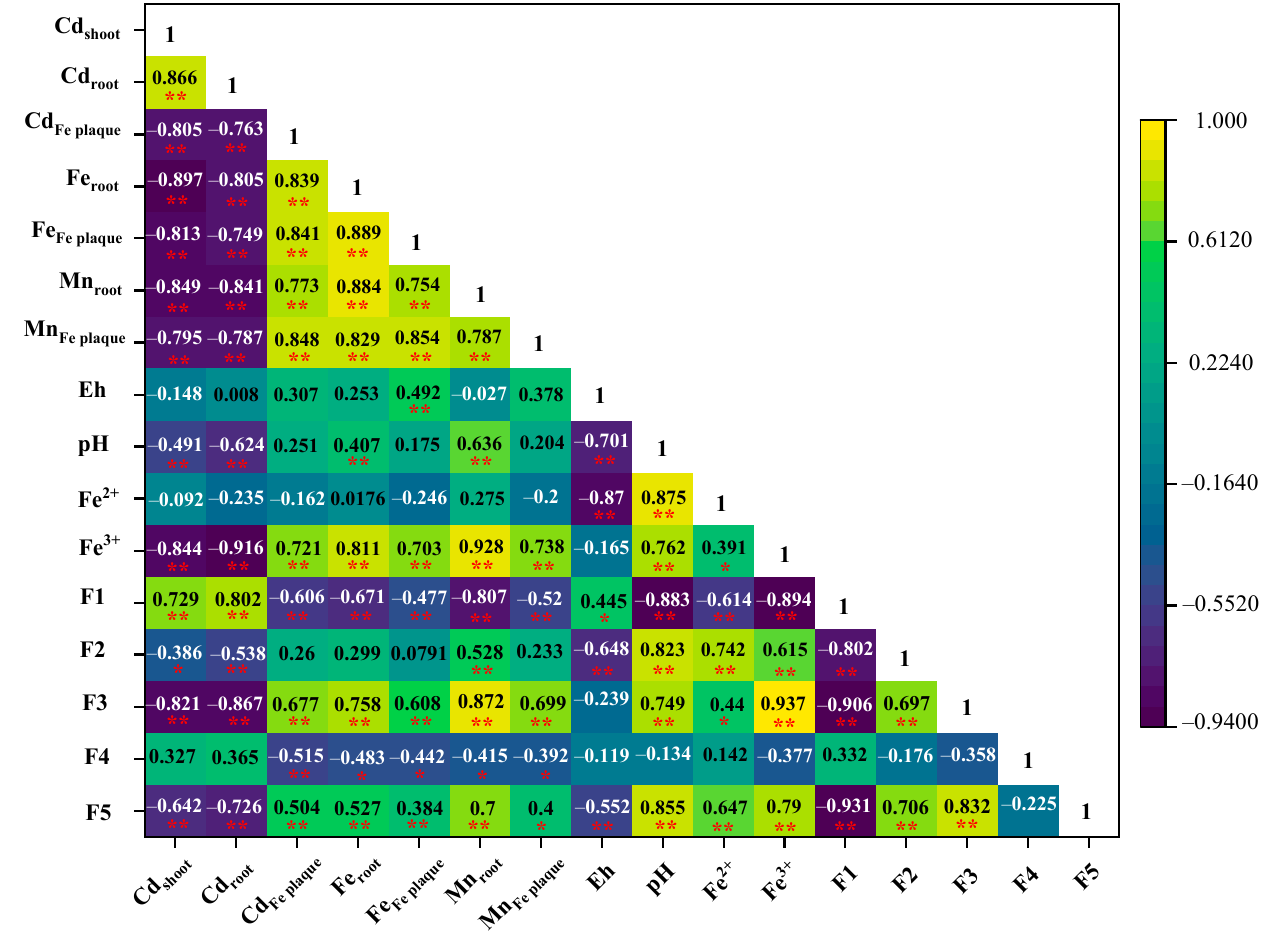
Figure 9. Correlations of Cd concentration in the shoot of rice and soil physicochemical variables. * p < 0.05, ** p < 0.01.